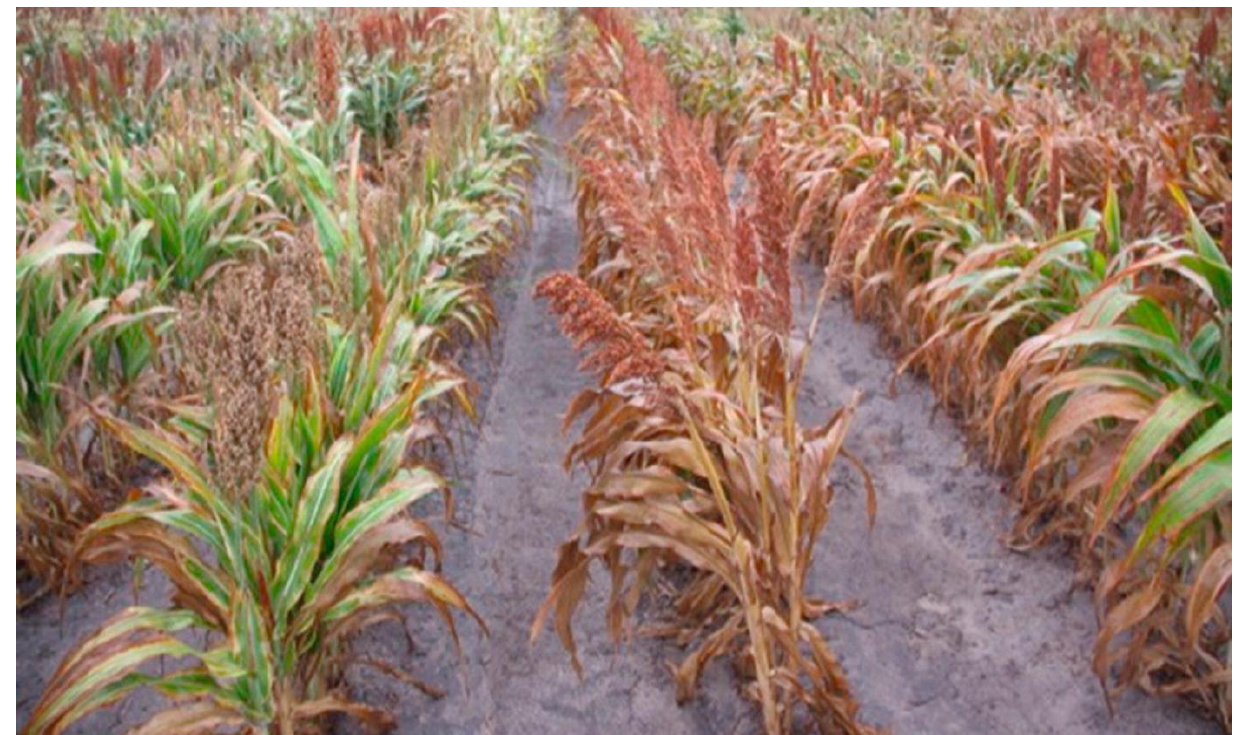
Figure 4. Expression of introgressed stay-green QTLs lines left and unintrogessed lines of sorghum, right, Photo—2019 .